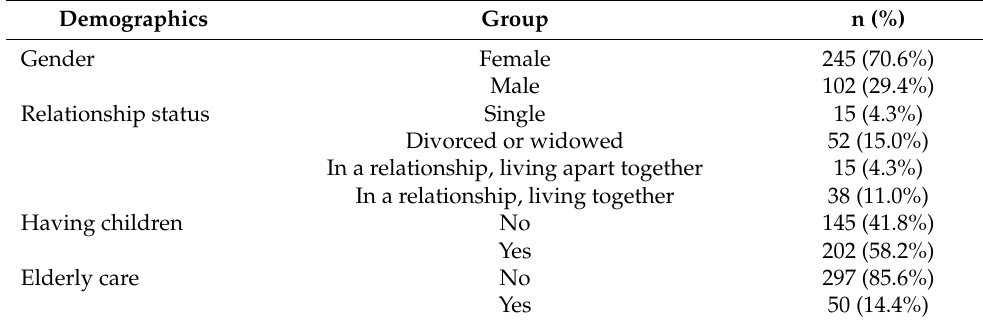
Table 1. Demographic